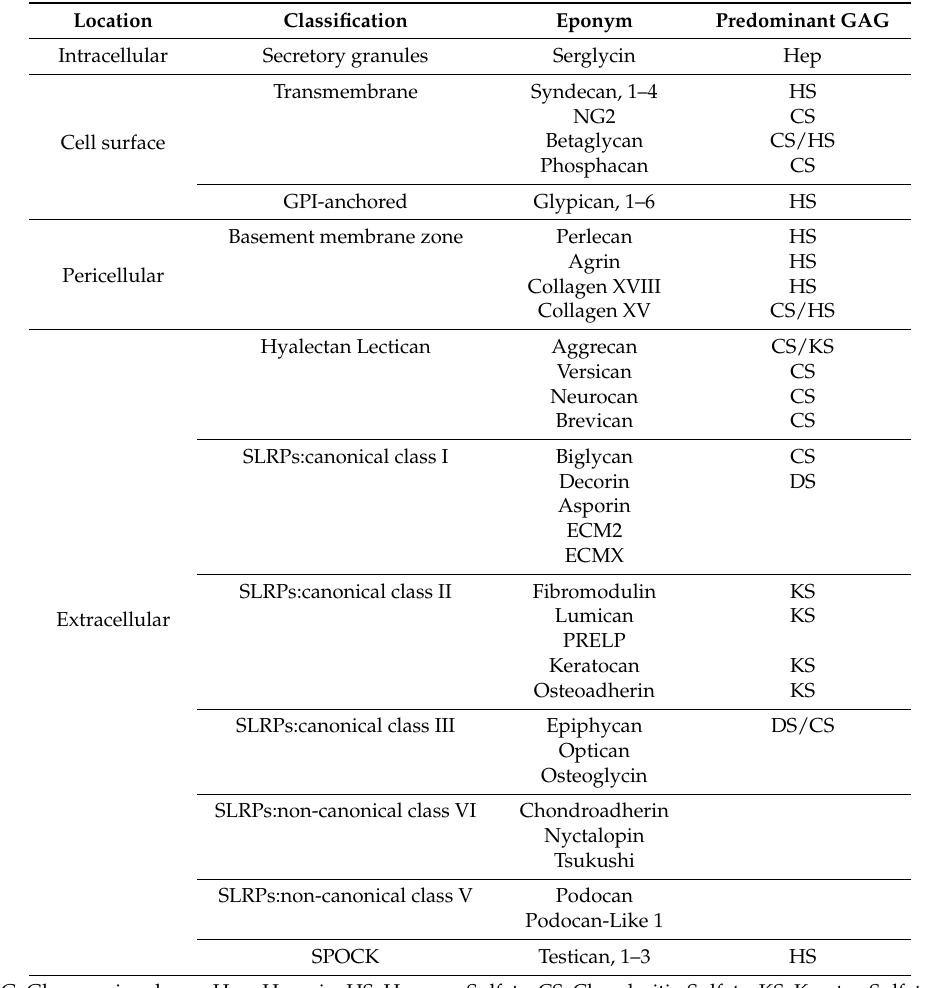
Table 1. A comprehensive classification of proteoglycans. (modified from Reference [4], Reproduced with permission from Iozzo, R.V. et al., Matrix Biology; published by Elsevier,